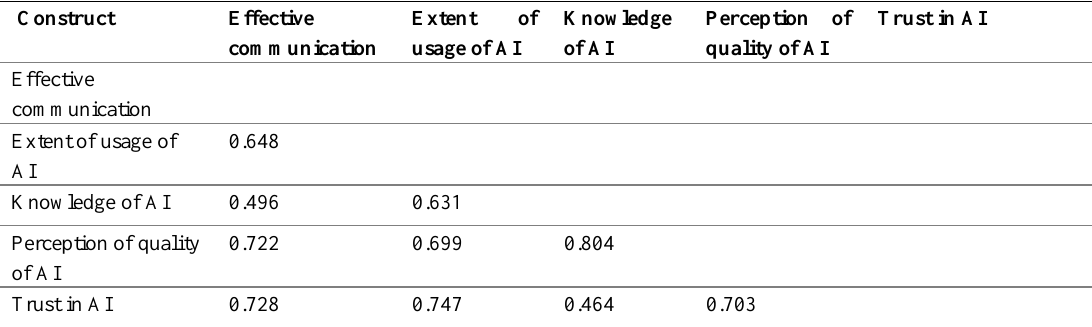
Table 6: Heterotrait-Monotrait Ratio